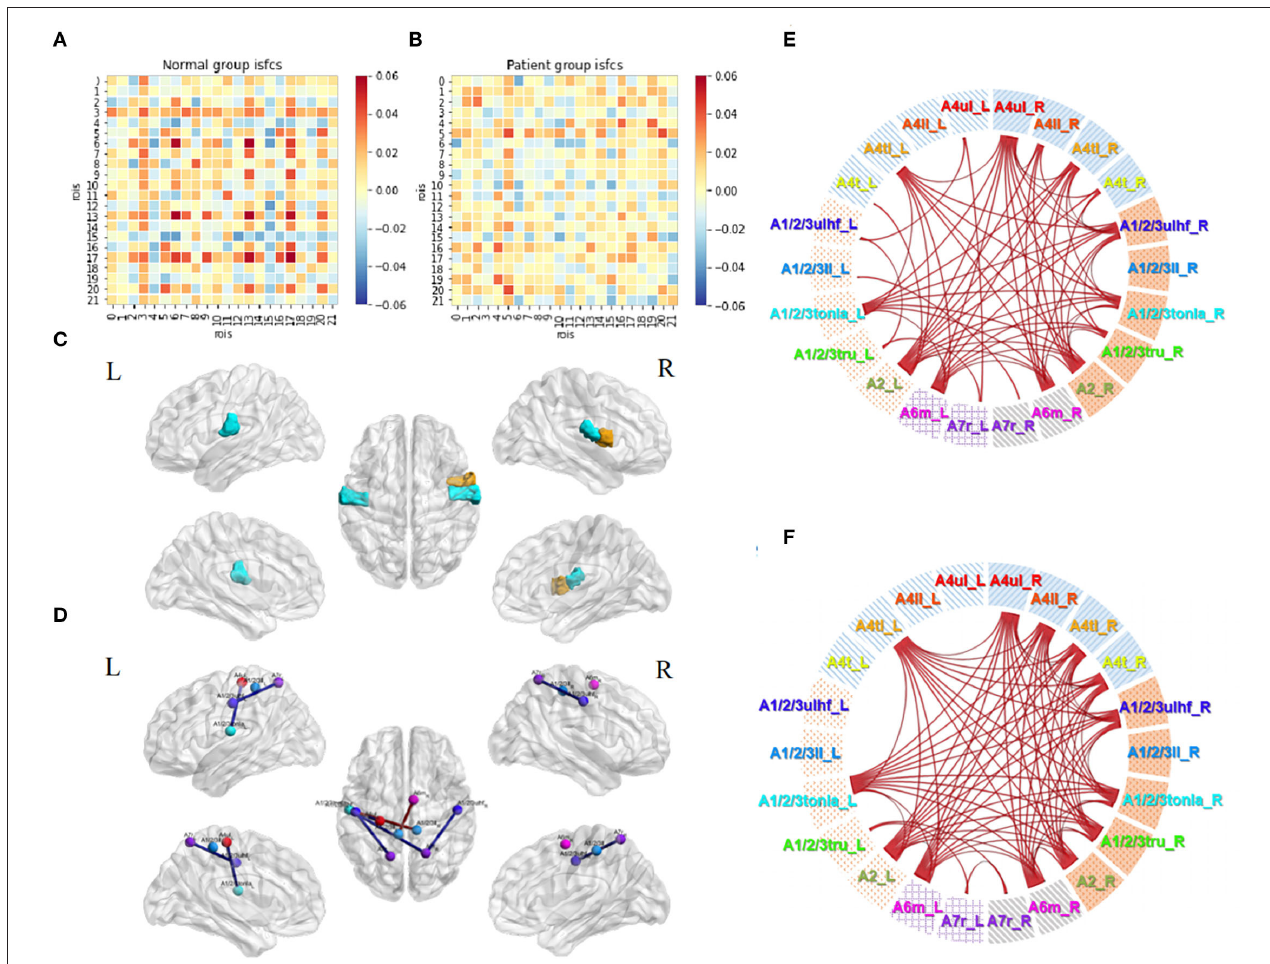
FIGURE 6 | Acupuncture task-stimulated ISC and ISFC. (A) ISFC matrix of 22 ROIs during acupuncture task in the control group. (B) ISFC matrix of 22 ROIs during acupuncture task in the patient group. (C) Significant ROIs in the control group during acupuncture ( p < 0.05, FDR-corrected). (D) Significant positive (lines in red) and negative (line in blue) ISFCs during acupuncture in the patient group ( p < 0.05, FDR-corrected). (E) Significant ISFCs between motor task vs. acupuncture task in the control group ( p < 0.01, FDR-corrected). (F) Significant ISFCs between motor task vs. acupuncture task in the patient group ( p < 0.01,